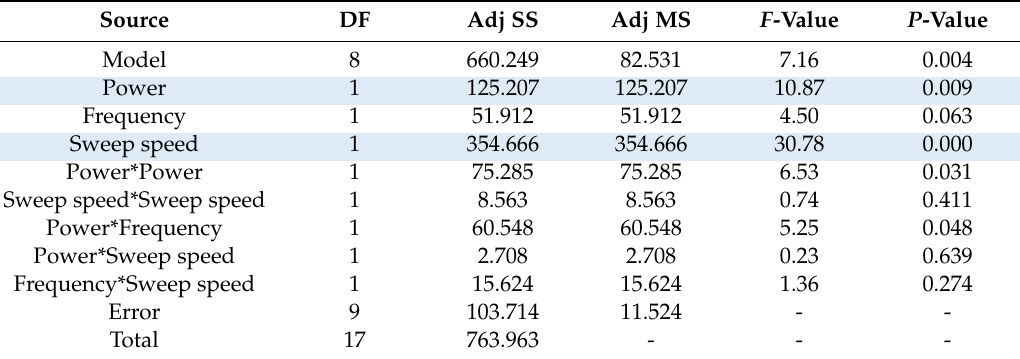
Table 6. ANOVA analysis of the surface quality obtained in laser texturing.